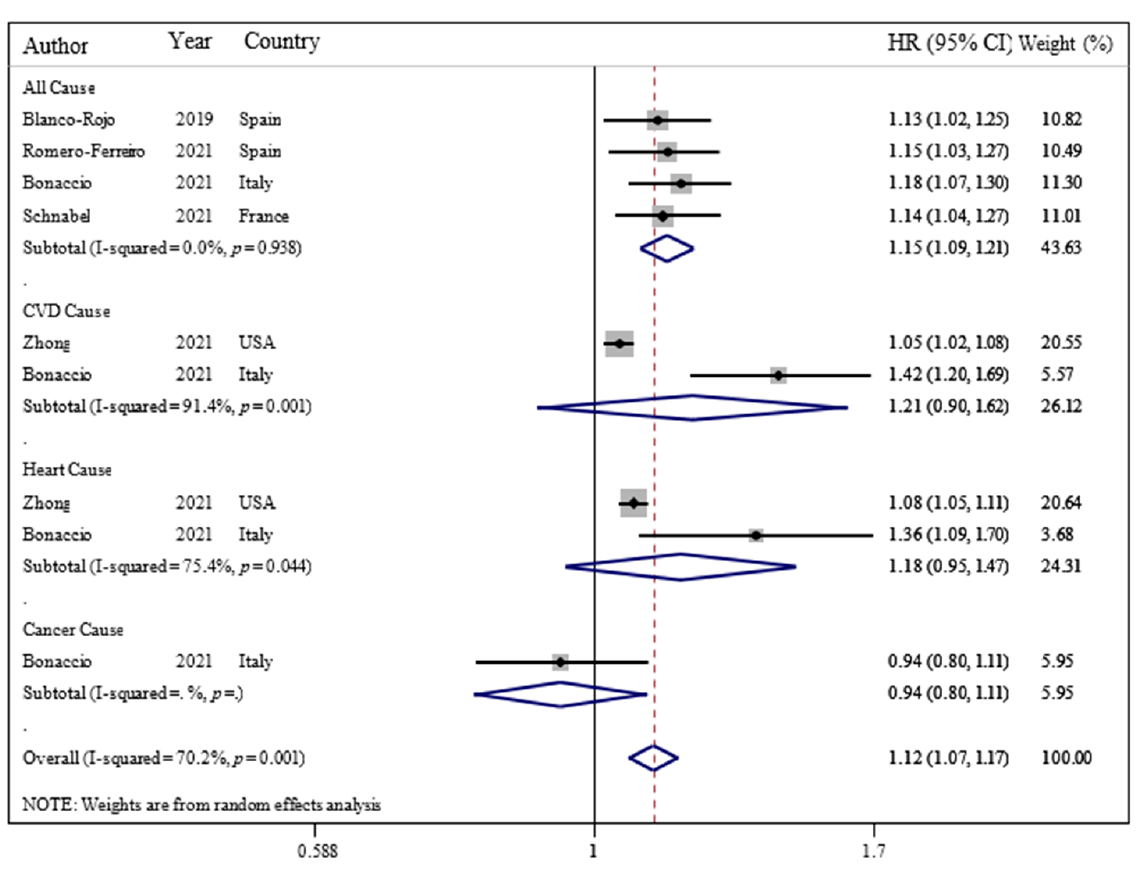
and the vertical dashed line represent the pooled HR, and its width represents the pooled 95 % CI.